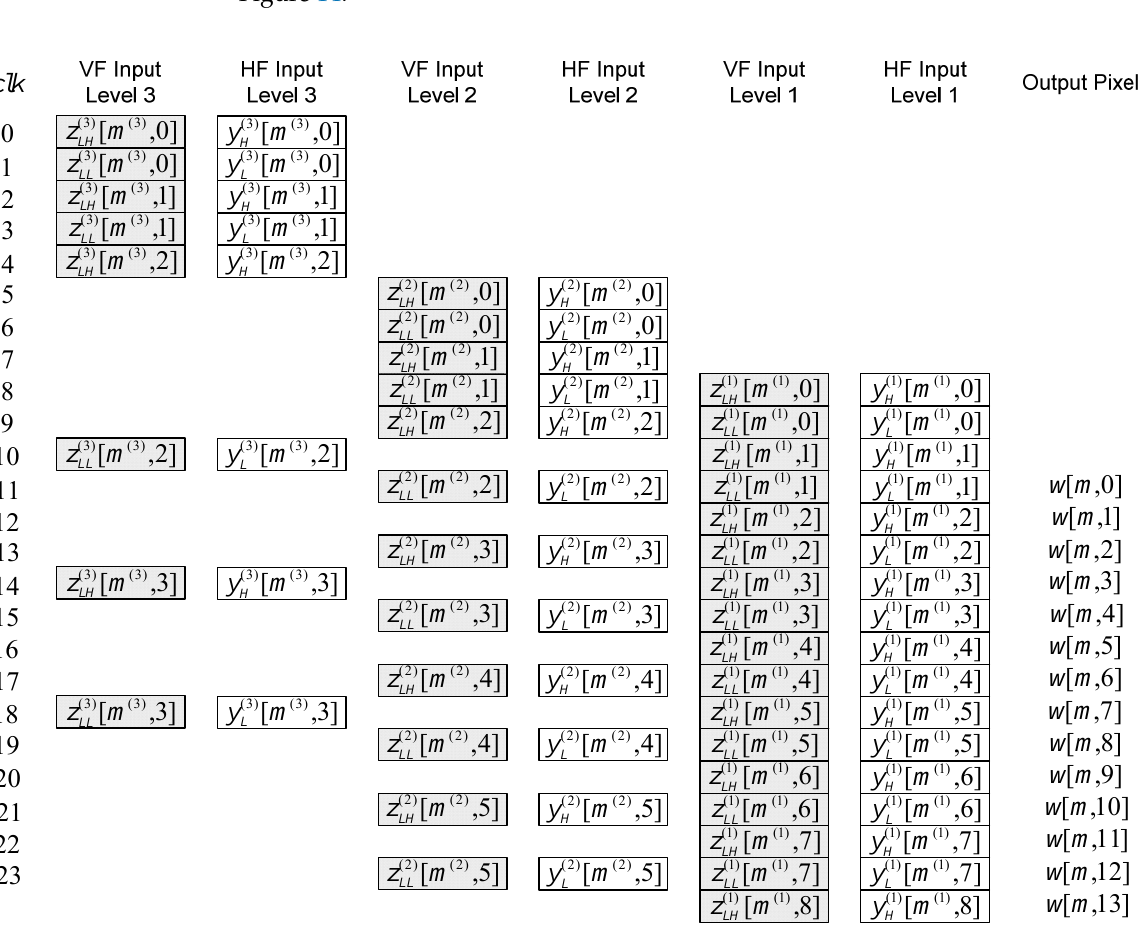
Figure 13. The time diagram of the 2 ‐ D inverse DWT 5/3 filtering at the beginning of even lines.